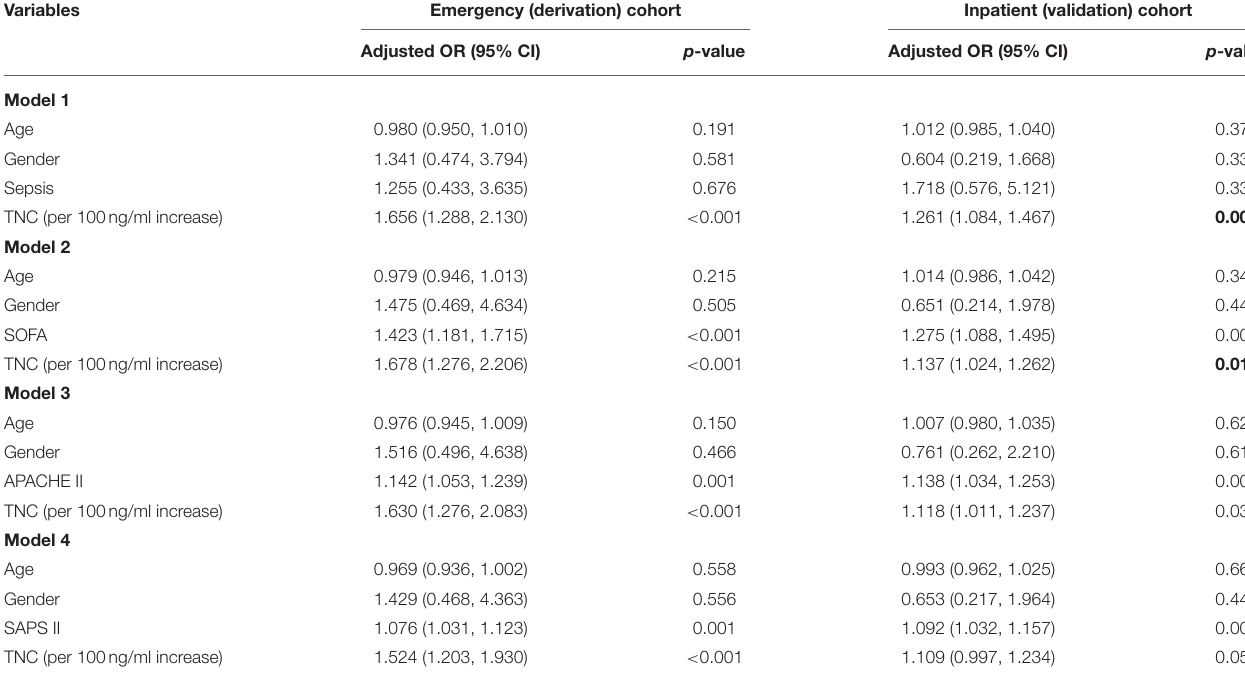
TABLE 2 | Multivariate analysis for risk factors of all-cause mortality in patients with multiple organ dysfunction. Variables